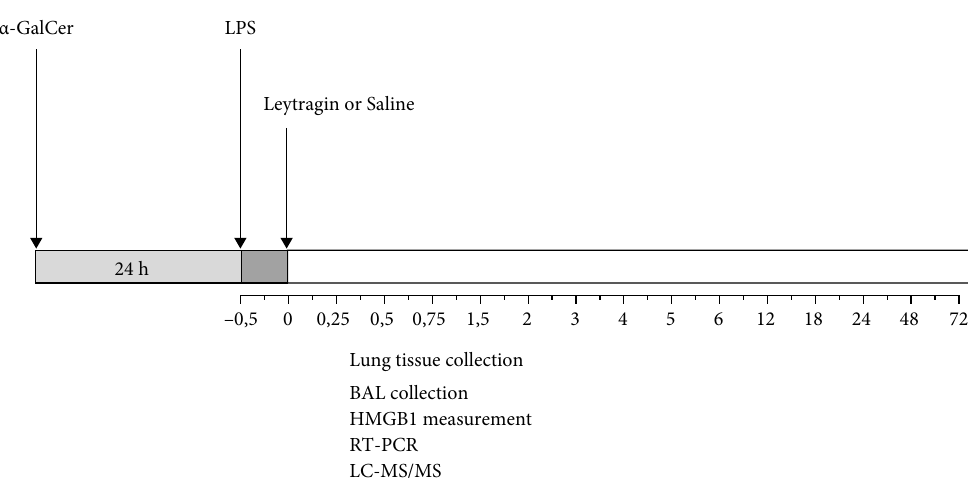
Figure 1: Experimental schedule of the present